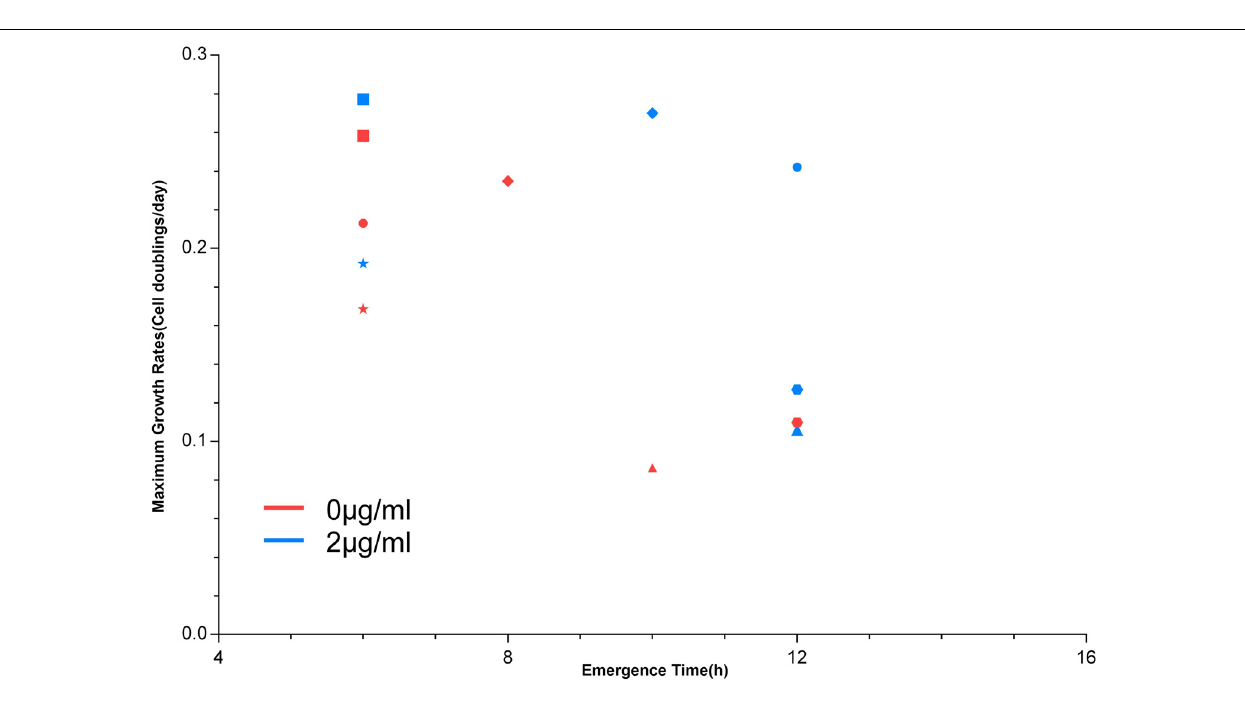
FIGURE 3 | The emergence time of the maximum growth rate. The maximum growth rate emergence time of six strains in the growth process. Circle: S1’; triangle: S26’; rhombus: S29’; square: S32’; hexagon: S34’; pentagon: